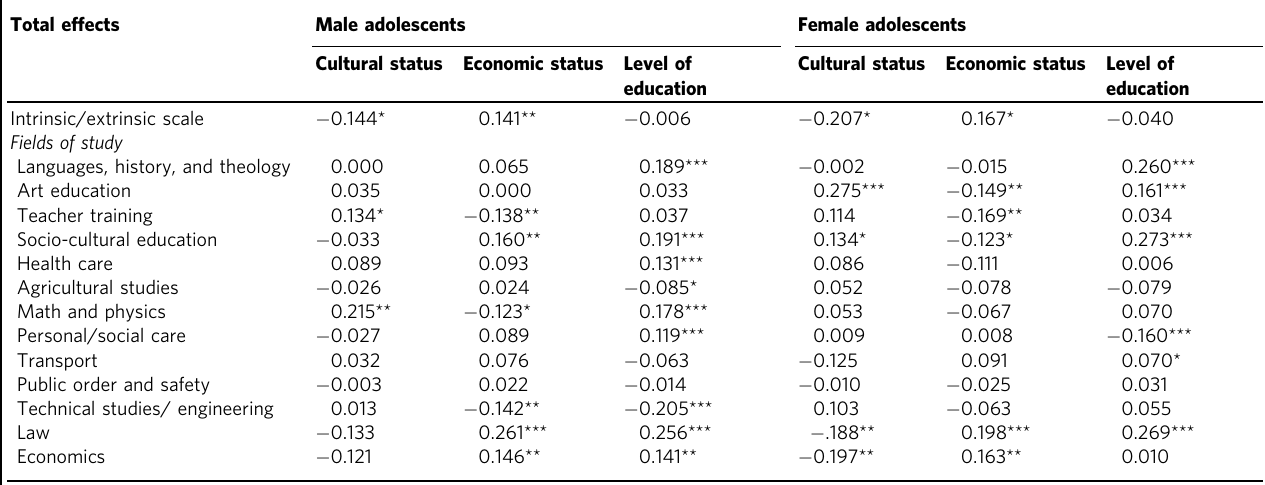
Table 3 The total effects of cultural- and economic status of the parents, and current level of education of the adolescent on the intrinsic/extrinsic scale and the speci fi c fi elds of study.